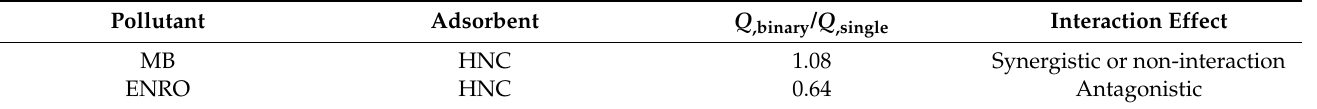
Table 3. Interaction effect of MB and ENRO adsorption onto HNC in the binary